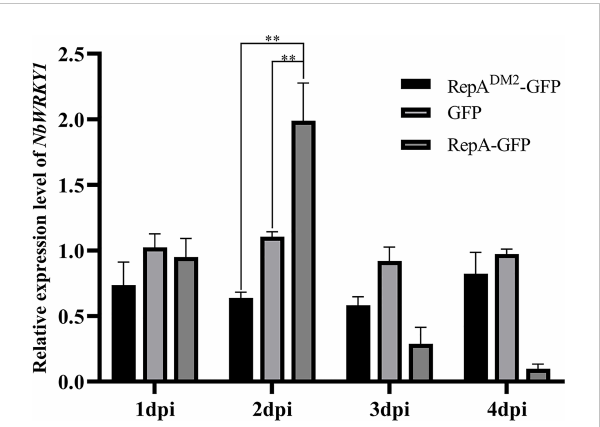
FIGURE 7 Relative expression of NbWRKY1 in response to transient expression of RepA DM2 -GFP, GFP, and RepA-GFP. Total RNA extracted at 4 days post-in fi ltration (dpi) was used for reverse transcription quantitative PCR (RT-qPCR) analysis. Signi fi cant differences (** p < 0.01) were determined with the Student ’ s t-test. The experiment was repeated four times with four independent biological